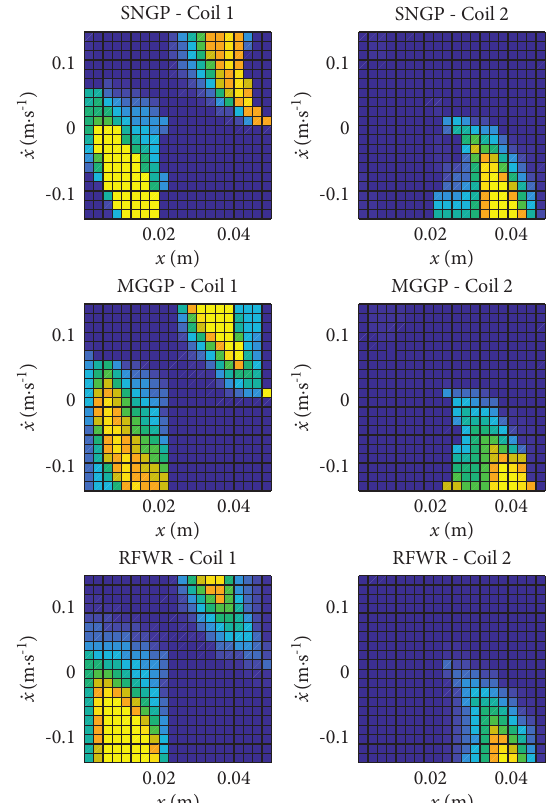
Figure 7: Comparison of policies based on the best fitting models of the magnetic manipulator from each of the approximation methods.